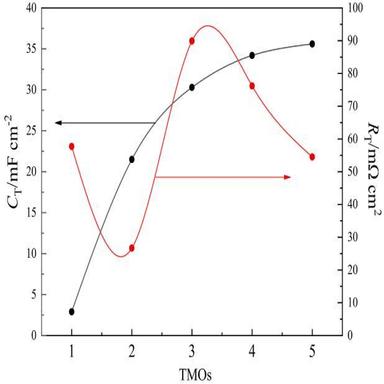
Average values of the overall specific capacitance and resistance calculated using the ANOVA statistics analysis for the different electrochemical data obtained using the CV, SSC, GCD, and EIS techniques according to the GE model proposed in this work.